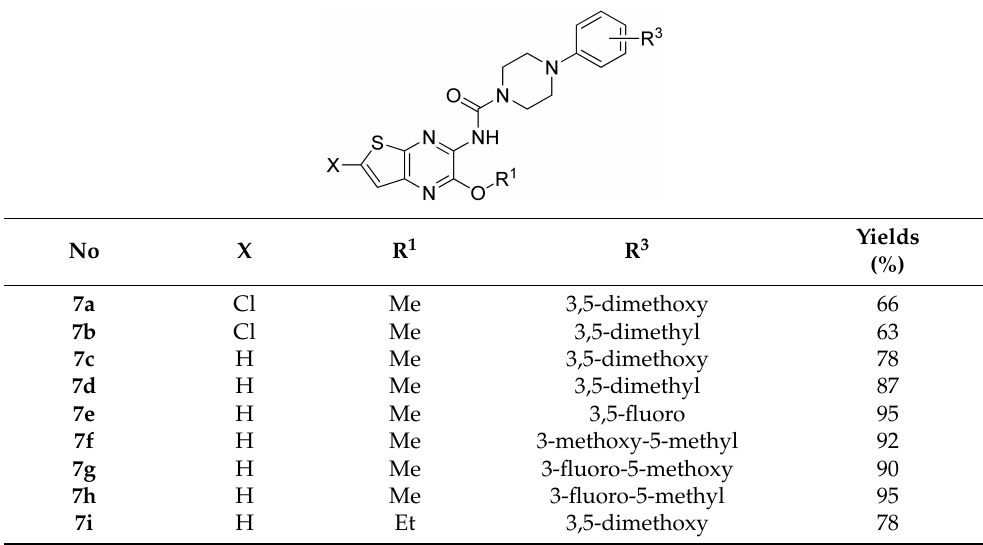
Table 1. Yields of 4-Phenyl- N -(thieno[2,3- b ]pyrazin-3-yl)piperazine-1-carboxamide Derivatives 7 .